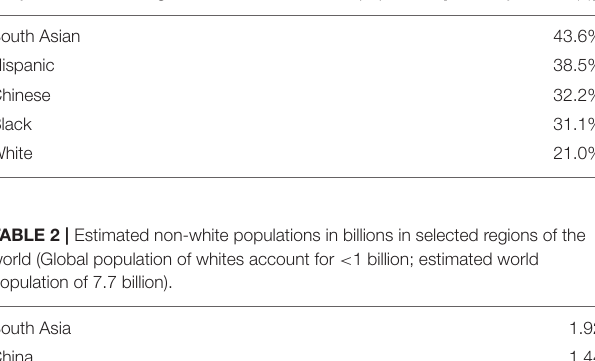
TABLE 1 | Percentage of combined cardiometabolic abnormalities and excess body fat in normal-weight non-obese mixed U.S. population [from Gujral et al. (3)].